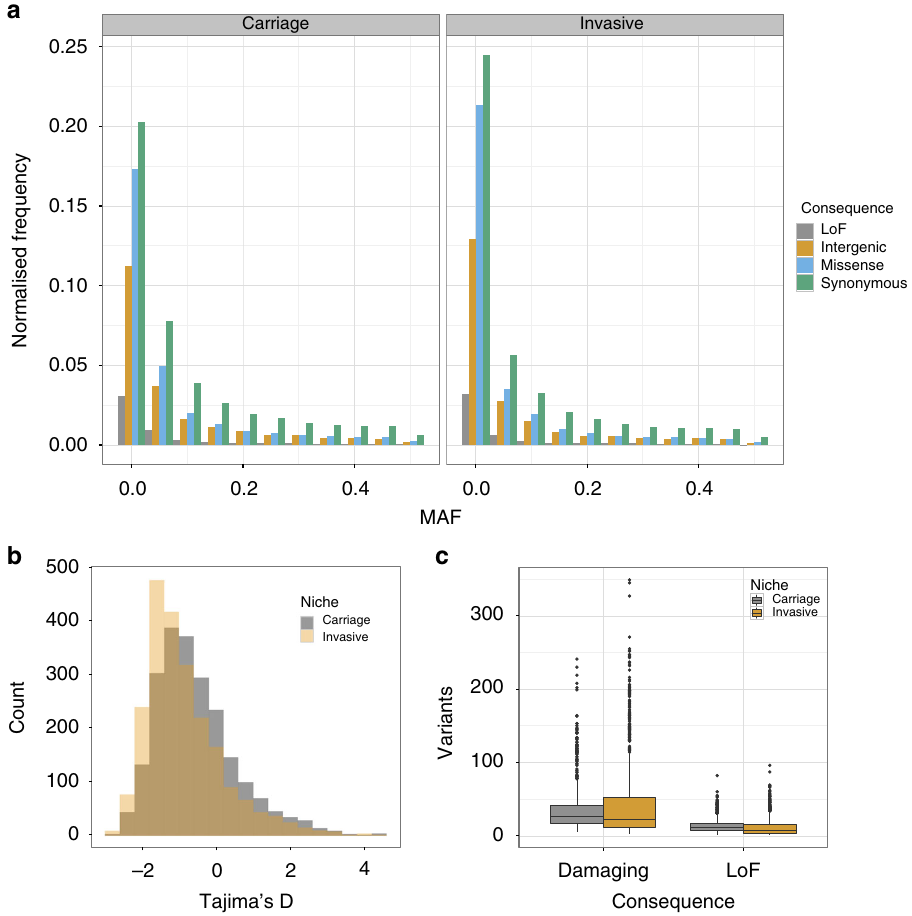
Fig. 2 Burden of rare variation between invasive and carriage isolates, based on mapping and calling short variants against a single reference genome. Loss- of-function (LoF) are frameshift or nonsense mutations. a The site frequency spectrum (SFS) strati fi ed by niche and by predicted consequence. Frequency has been normalized with respect to the number of samples in each population. b Histogram of Tajima ’ s D for all coding sequences in the genome, strati fi ed by niche. c Boxplot of the number of rare variants per sample, strati fi ed by niche and predicted consequence. Damaging mutations are LoF mutations and missense mutations predicted damaging by PROVEAN. Centre line is the median, box spans lower to upper quartiles. Whiskers show the outlier range, de fi ned as being >1.5× the interquartile range above or below the lower and upper